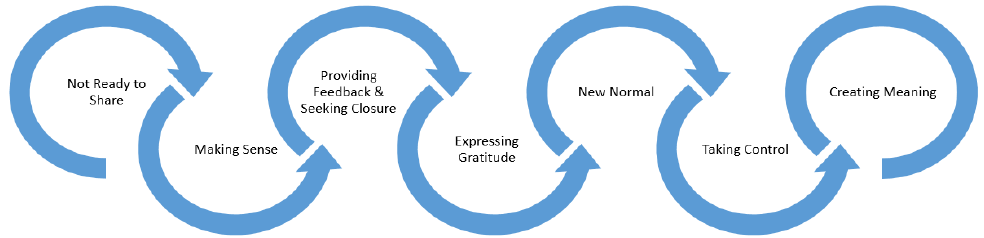
Figure 1. Pathway through COVID-19 Recovery. Participants progressed through the above steps during their COVID-19 recovery journey.